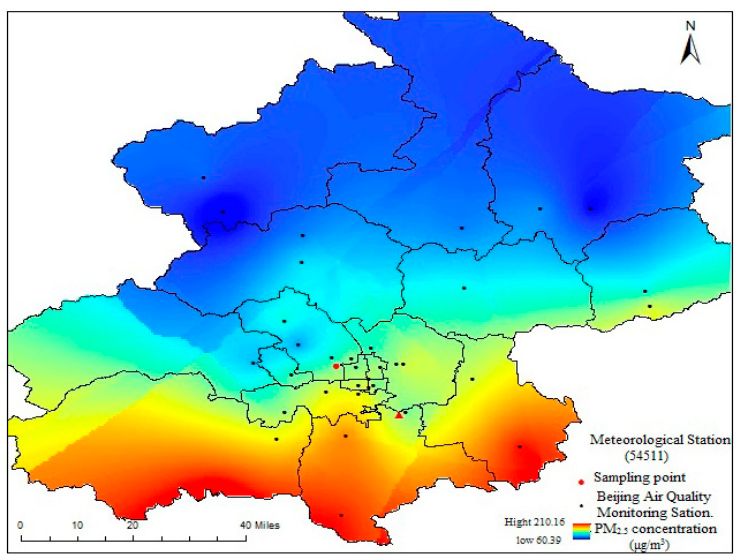
Figure 5. Spatial distribution of PM 2.5 during the sampling period in 2016.